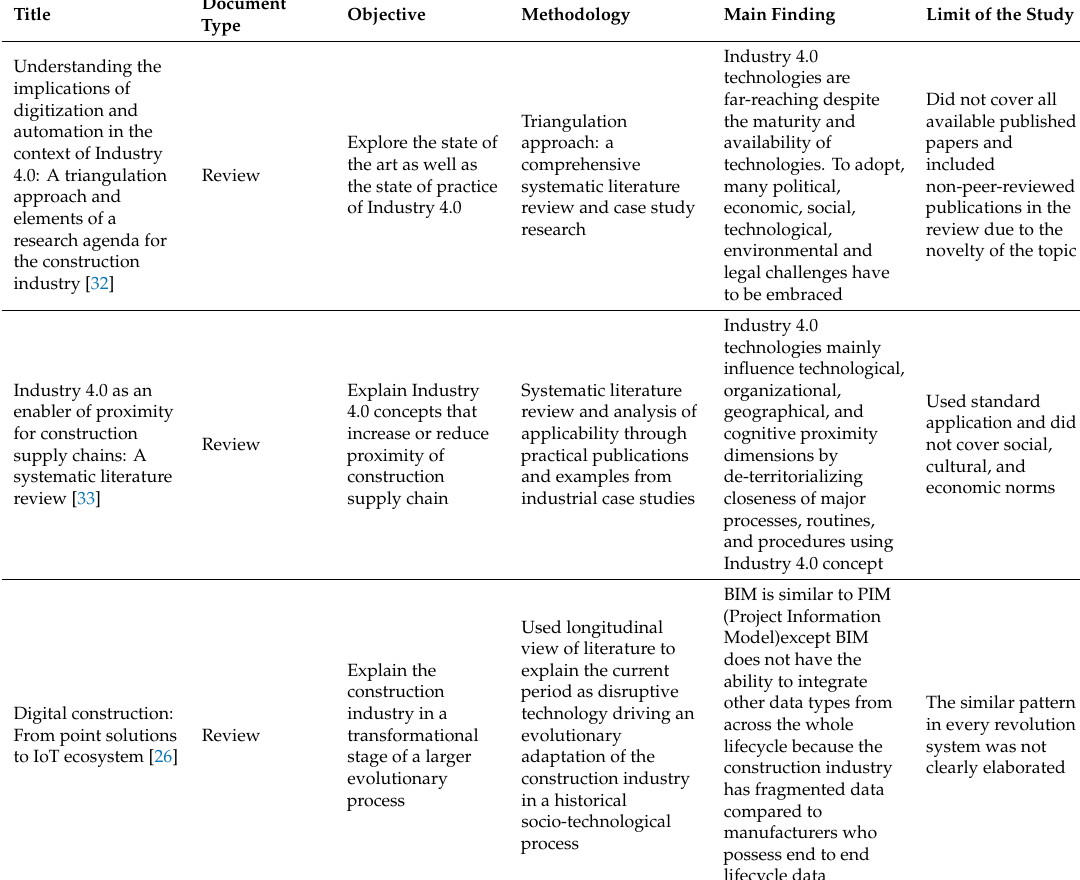
Figure 6. Sum of times cited per year of “Industry 4.0” OR “Industrial revolution 4.0” AND TOPIC “construction” OR “building” keyword from 2014–2019 in Scopus. Table 12. Summary of 20 targeted papers.